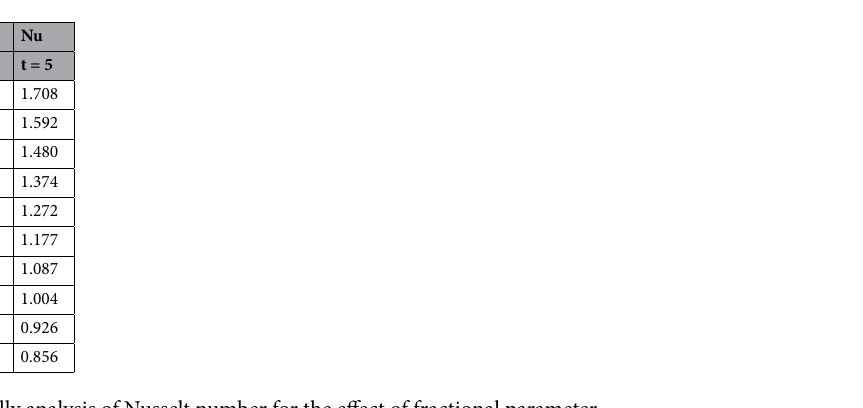
Table 6. Statistically analysis of Nusselt number for the effect of fractional parameter.